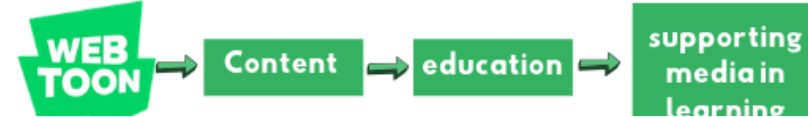
Picture: 5.5 Illustration of the development from the